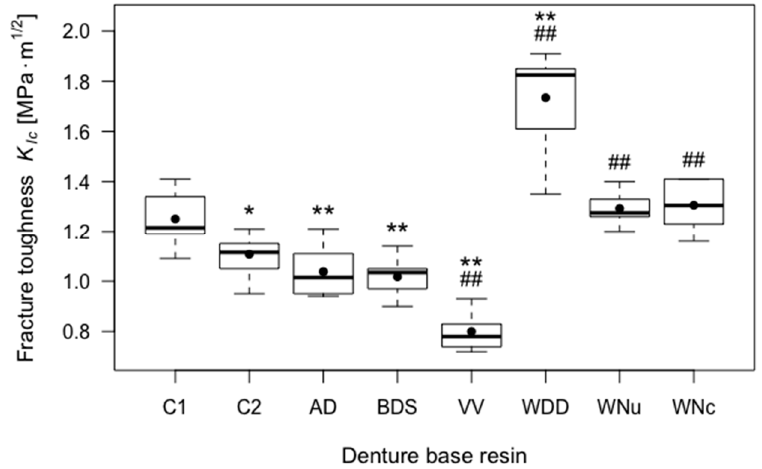
Figure 3. Boxplots of the fracture toughness ( K Ic ) of tested resins. Significant differences ( p < 0.05) with respect to control group C1 are indicated by *, highly significant differences ( p < 0.01) with respect to control group C1 are indicated by **, and ## indicates highly significant differences ( p < 0.01) with respect to control group C2.